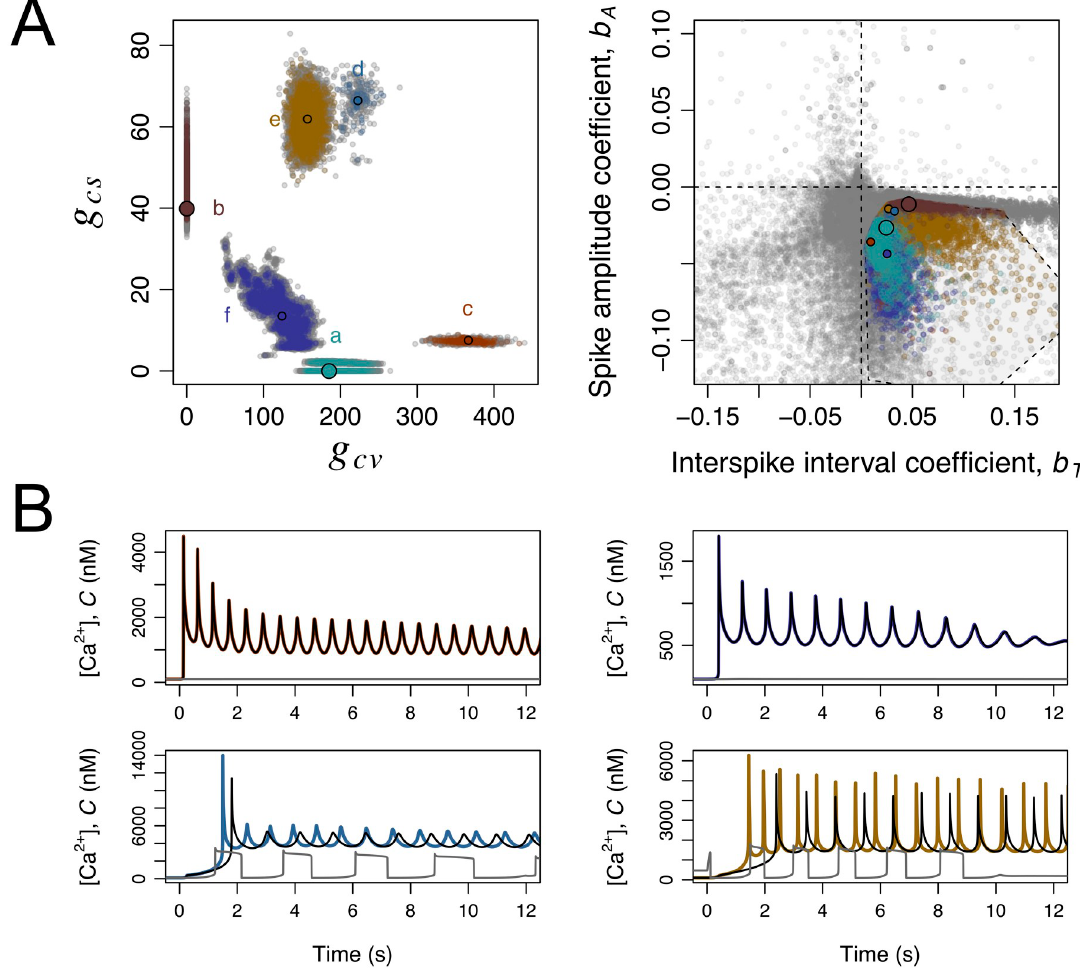
Fig 8. Exploration of mixed scenarios involving the components of the Ca V +BK and CatSper+NHE modules. The state space of the model was extended to { S , R , R , R , G , f o , f o , V , f o , f c , f o , f o , f a , C , H }. A large number of parameter vectors resulting from a search of F H L kn hc cv cv bk cs nh parameter space for coherence with experimental time series is illustrated in this figure according to clustering in the projection plane ( g cv , g cs ), predicted dynamics, and predicted functionality of the components of the two modules. During the exploration, coherence with experimental time series required that the resting C (0) is about 100nM, the average spike interval is in the range 0.37 s-1.38 s, the predicted ( b T , b A ) point falls within the convex hull of most representative experimental values in the bottom right quadrant (polygon in A, right). A) On the left, the clustering of the parameter vectors in projection in the ( g cv , g cs ) plane is shown. On the right, the envelope and temporal organisation of Ca-spike trains predicted by each of these parameter vectors is represented as the bivariate plot of the spike-amplitude coefficient b vs the interspike interval coefficient b . In both graphs the dots represent individual parameter vectors A T which are coloured according to the cluster if they are fully coherent with experimental time series (selected) and grey otherwise (unselected). For each cluster in the plane ( g cv , g cs ) a parameter vector has been singled out (smaller filled circles). The two larger filled circles represent the reference parameter vectors for Ca V +BK and CatSper+NHE modules. B) Illustration of the dynamics corresponding to the parameters vectors singled out in clusters c (top left), d (top right), e (bottom left) and f (bottom right) in A. The curves are the numerical solutions of the variable C in the model under the full parameter vector (coloured according to the cluster), setting g cs = 0 (black) and setting g cv = g bk = 0 (grey). Notice the overlap between coloured and black curves on the graphs on